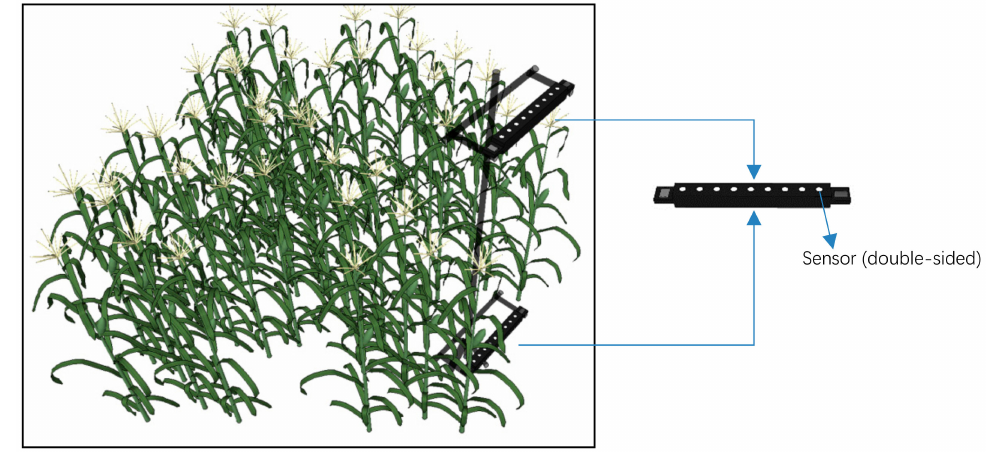
Figure 1. Automatic observation diagram of the